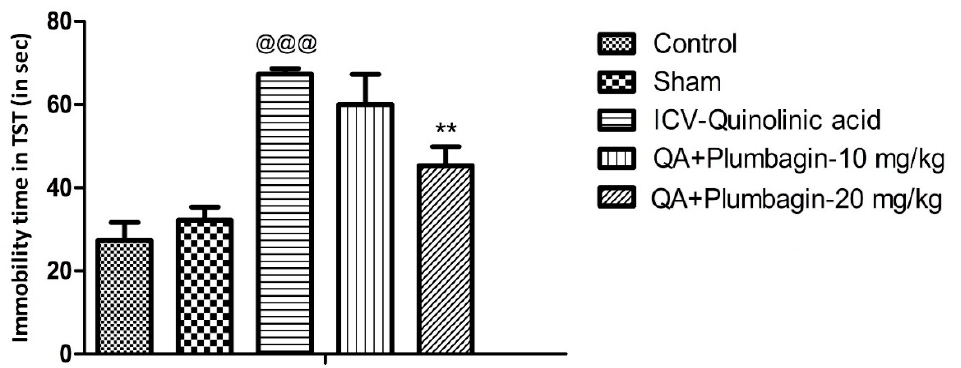
Figure 2. Effect of plumbagin on QA-induced increased in immobility time during the Tail Suspension Test. Data represent mean ± SEM ( n = 6). @@@ p < 0.001 as compared to control group; ** p < 0.01 as compared to QA-induced group.